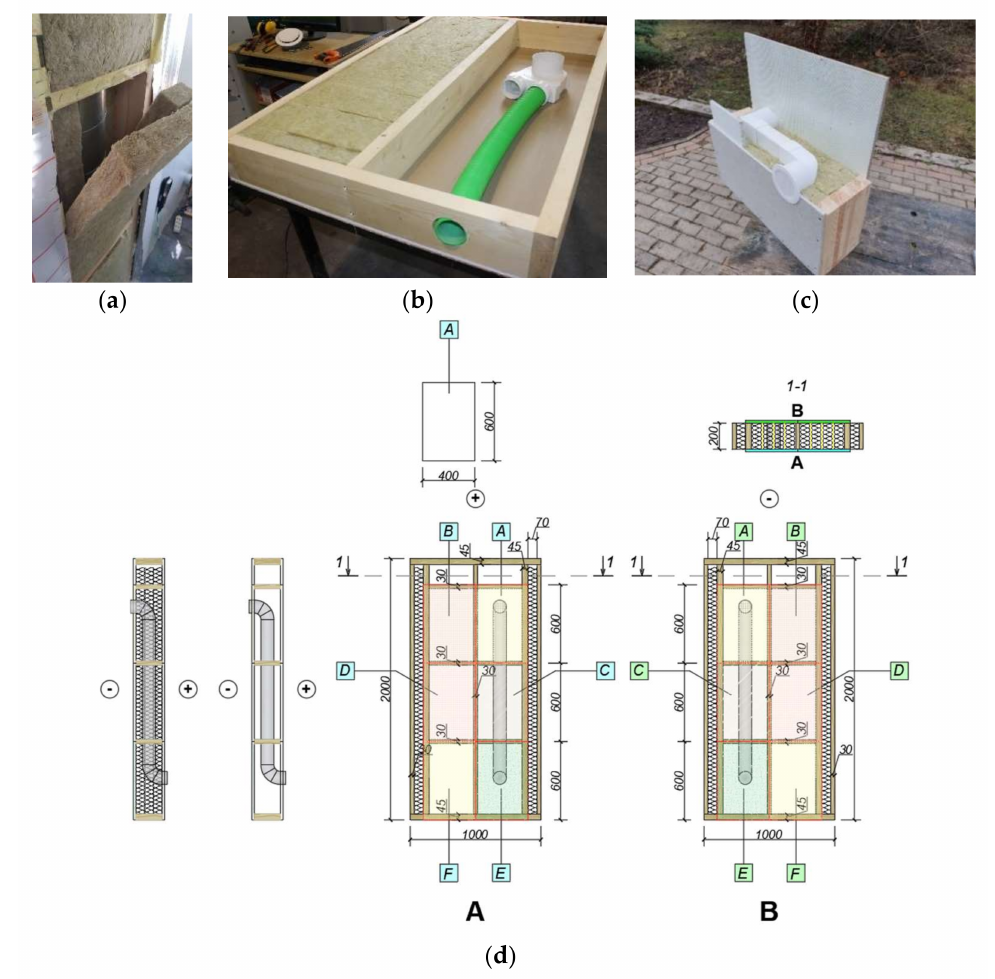
Figure 1. Wooded frame test construction. ( a ) steel duct; ( b ) flexible plastic duct; ( c ) plastic ducts; ( d ) test wall